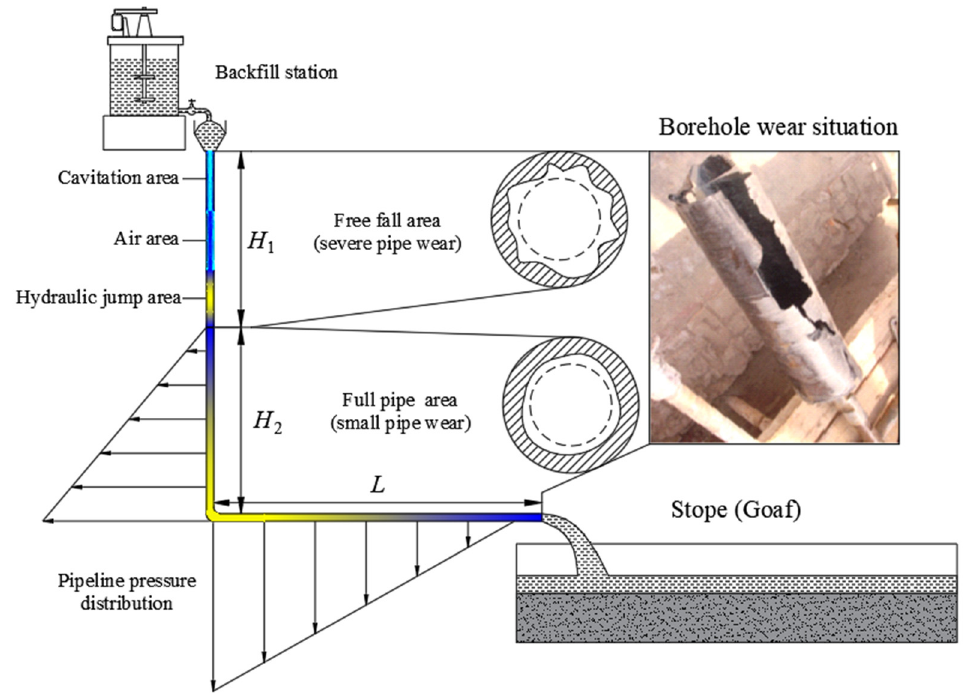
Figure 3. Analysis of self-flow transportation mode and wear of backfill slurry pipeline.